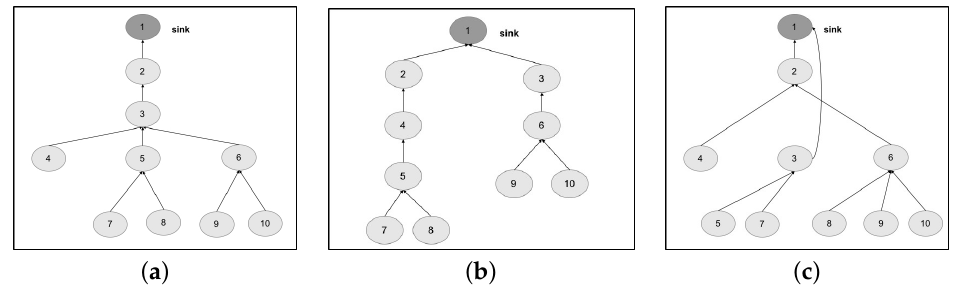
Figure 11. Topologies of MEDiSN. ( a ) Original; ( b ) First attempt; ( c ) Second attempt.